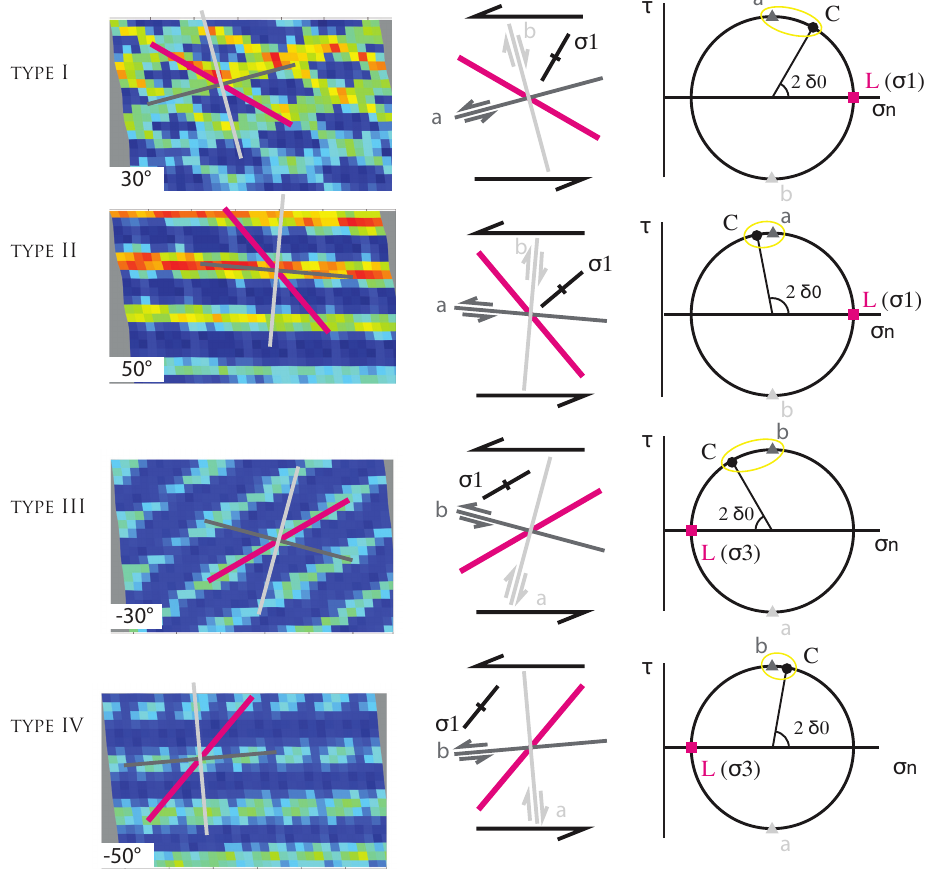
Fig. 8. Left column: finite strain at γ = 0 . 1 with the layering direction a purple line and the maximum shear stress directions (a and b) are reported by grey lines. Middle and right columns: the black arrows represent the bulk simple shear imposed at the boundary, and is represented as the black C dot on the Mohr circle. The cross indicates the local principal stress direction as deduced from the Mohr circle construction in the right column. The layering is represented by a purple square on the Mohr circle and also corresponds to one of the principal stress